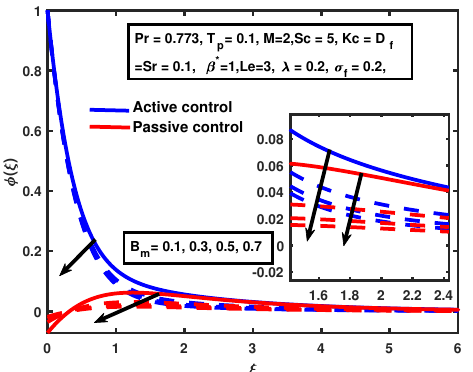
Figure 18. The impact of φ ( ξ ) on Brownian motion B m .